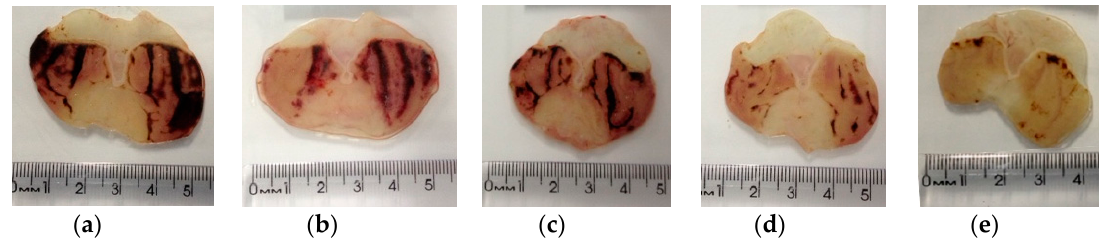
Figure 6. Typical photograph of the gastroprotective effect of aqueous extract of X. americana (XaAE) stem bark on ethanol/HCl-induced (0.3 M HCl/60% ethanol, 1 mL, orally) gastric lesions in rats. ( a ) Lesioned control (NaCl 0.9%, 10 mL/kg, orally); ( b ) pantoprazole (40 mg/kg, orally); ( c – e ) XaAE (100, 200 and 400 mg/kg, orally, respectively).